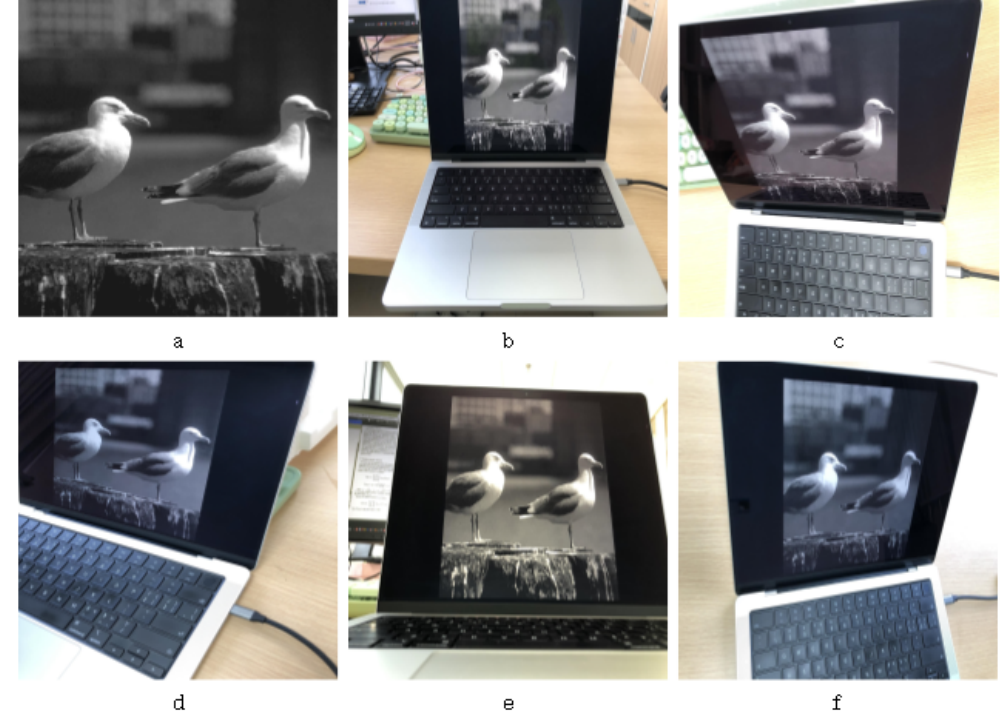
Figure 1. Real leak cases: ( a ) original image, ( b ) screen-shooting image with front view, ( c ) screen- shooting image with vertical perspective angle (up), ( d ) screen-shooting image with horizontal perspective angle (right), ( e ) screen-shooting image with vertical perspective angle (down), ( f ) screen- shooting image with horizontal perspective angle